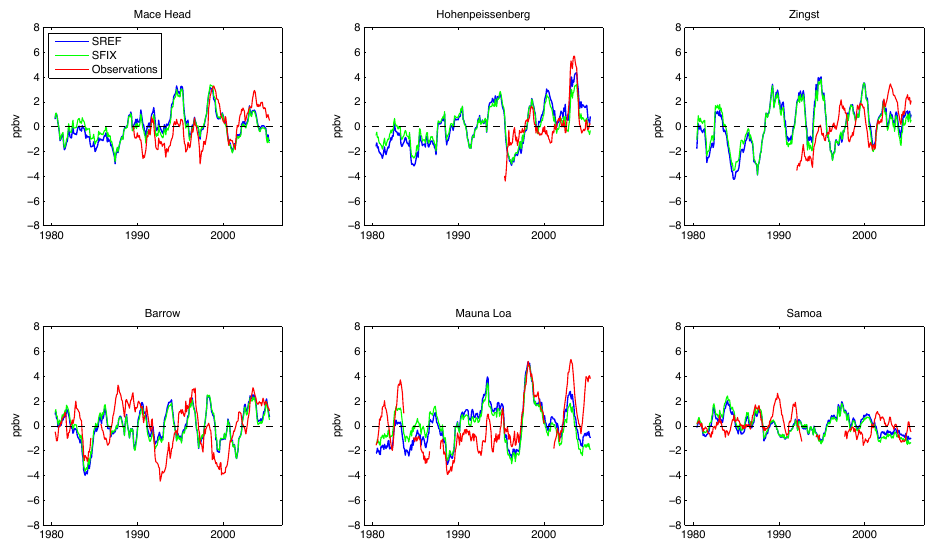
Fig. B1. Time evolution (1980–2005) of surface ozone monthly mean anomalies (12-month running mean) at a variety of remote sites. Observations are in red, ECHAM5-HAMMOZ results are in blue (SREF simulation) and green (SFIX